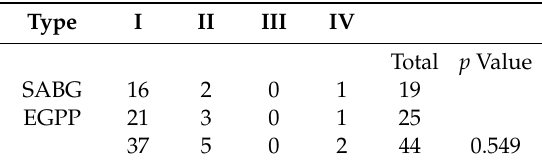
Table 3. Bergland scale score.